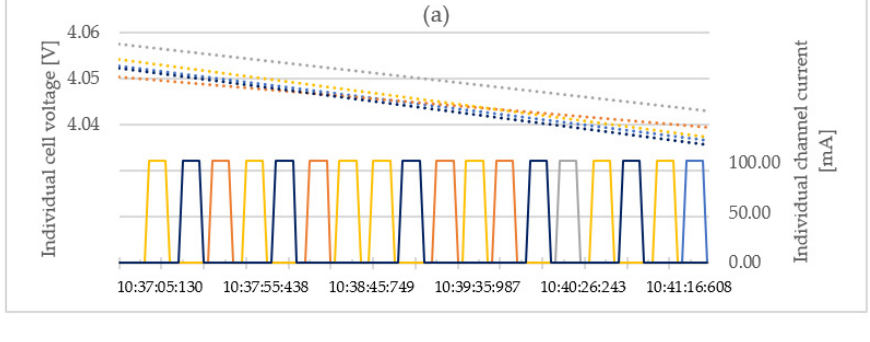
Figure 17. Initial ( a ) and final ( b ) battery-cell voltage (trendlines) and balancing channels current oscillograms in the discharge system configuration.